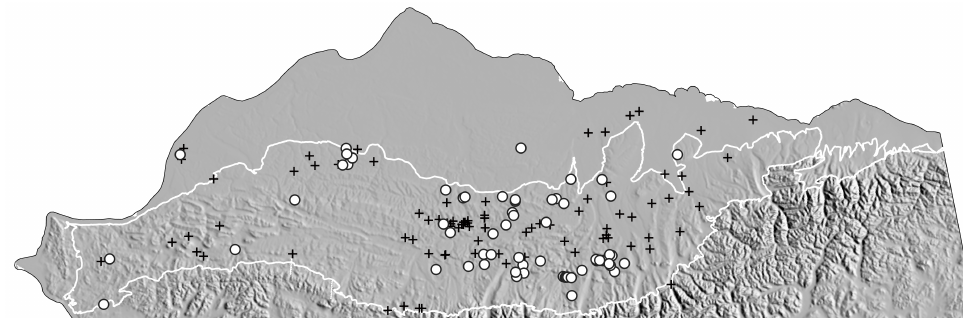
Figure 6. Locations of recorded (pluses) and unrecorded (circles) tundra burns. The area depicted is the same as in Figure 1. The Brooks Range Foothills ecoregion is outlined in